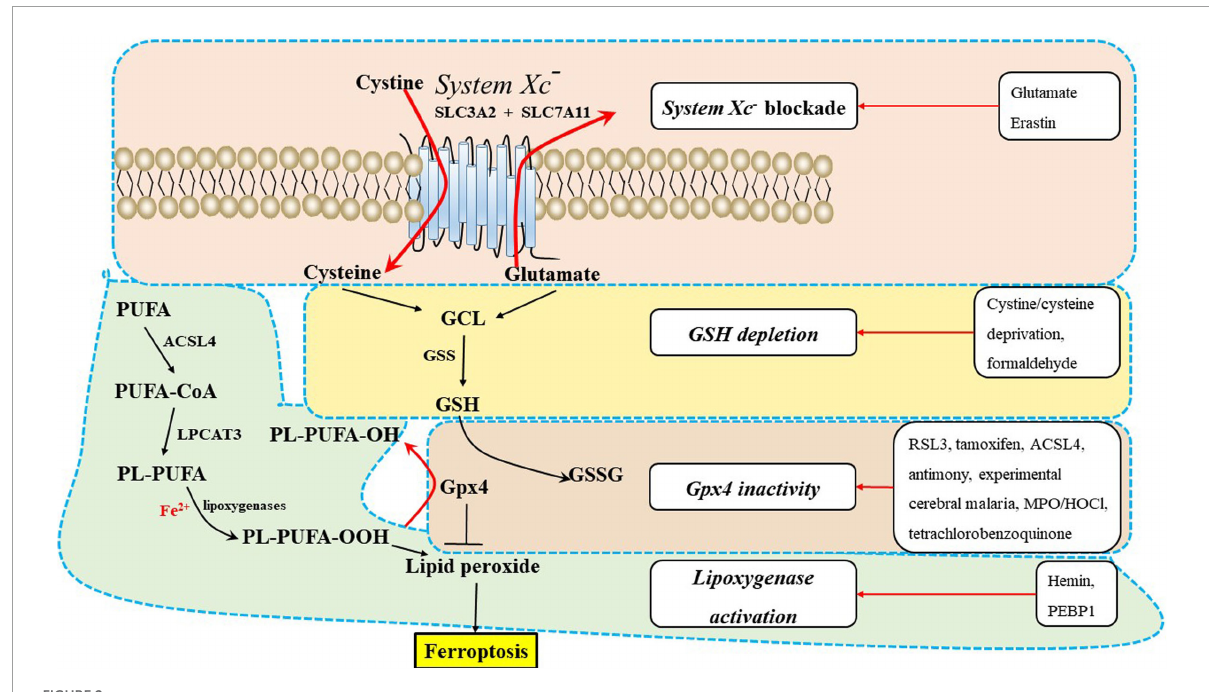
FIGURE2 The underlying mechanisms of ferroptosis regulation in the central nervous system (CNS). Ferroptosis inducers are shown in the box, including system Xc - blockade, GSH depletion, Gpx4 inactivity, and lipoxygenase activation. ACSL4, acyl-CoA synthetase long-chain family member 4; GPX4, glutathione peroxidase 4; GSH, glutathione; GSS, glutathione synthetase; LPCAT3, lysophosphatidylcholine acyltransferase 3; PEBP1, phosphatidylethanolamine-binding protein 1; PUFA-CoA, polyunsaturated fatty acid; PL-PUFA, polyunsaturated fatty acid (PUFA)-phospholipids; PL-PUFA-OOH, phospholipid hydroperoxide; MPO/HOCl, myeloperoxidase/hypochlorous acid.